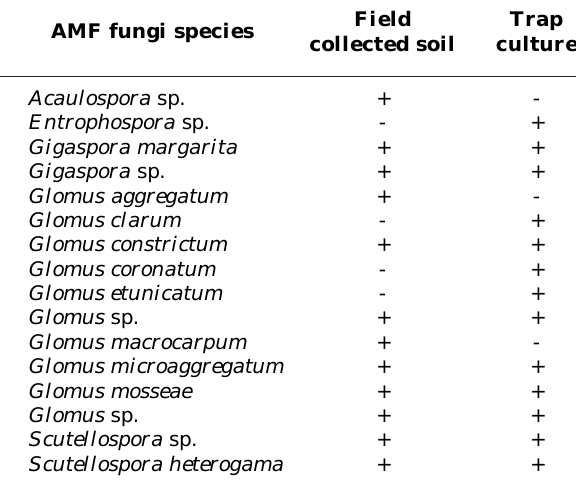
Table 5. Mycorrhizal fungal species present in soil collected from Permanent Pasture or obtained in trap cultures